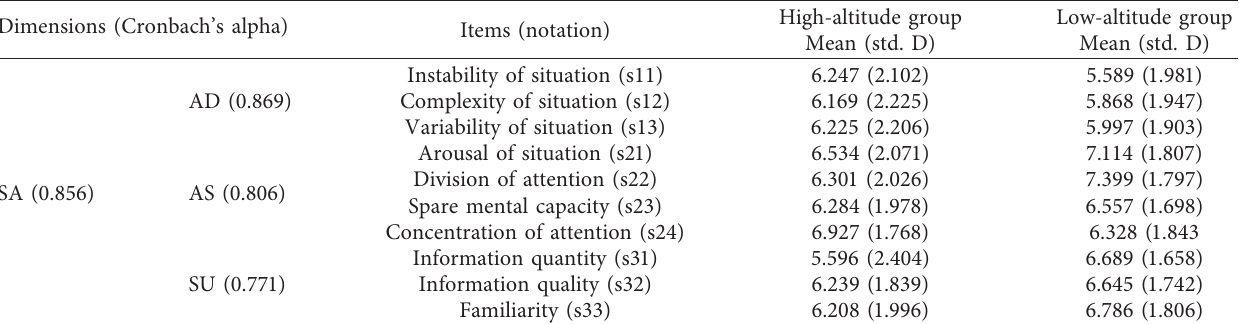
Table 2: Results of internal consistency and